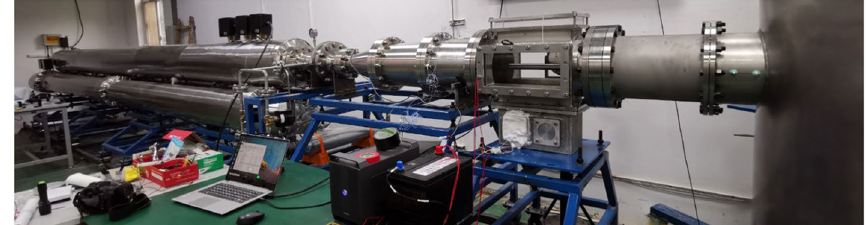
Fig. 1 Mach 6 Ludwieg tube tunnel in Huazhong University of Science and